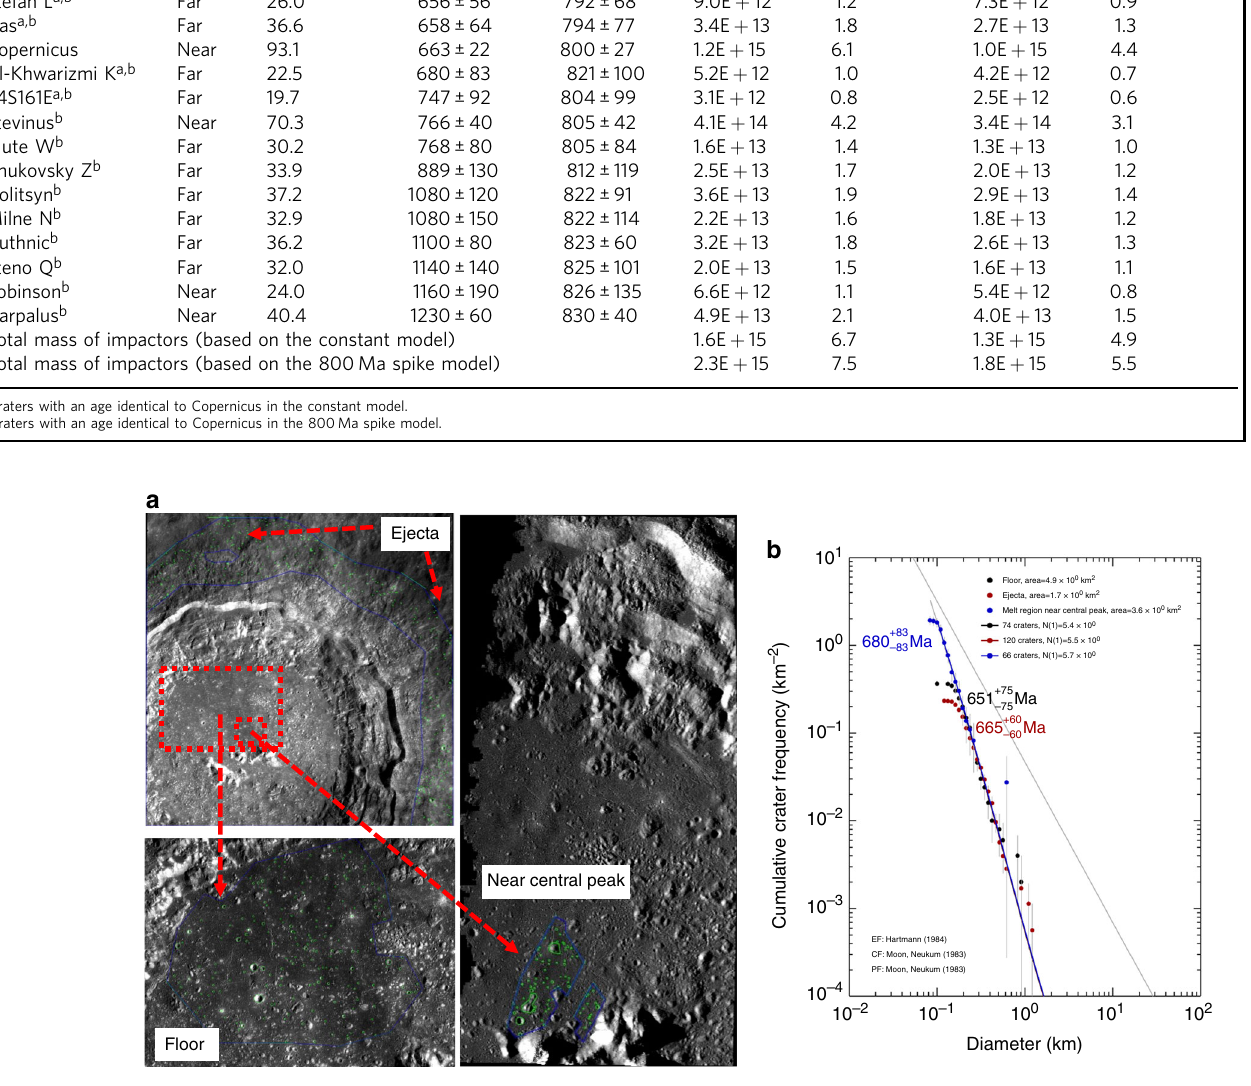
Fig. 4 The Terrain Camera images and their cumulative size-frequency distributions in various regions of Copernicus crater. The terrain camera